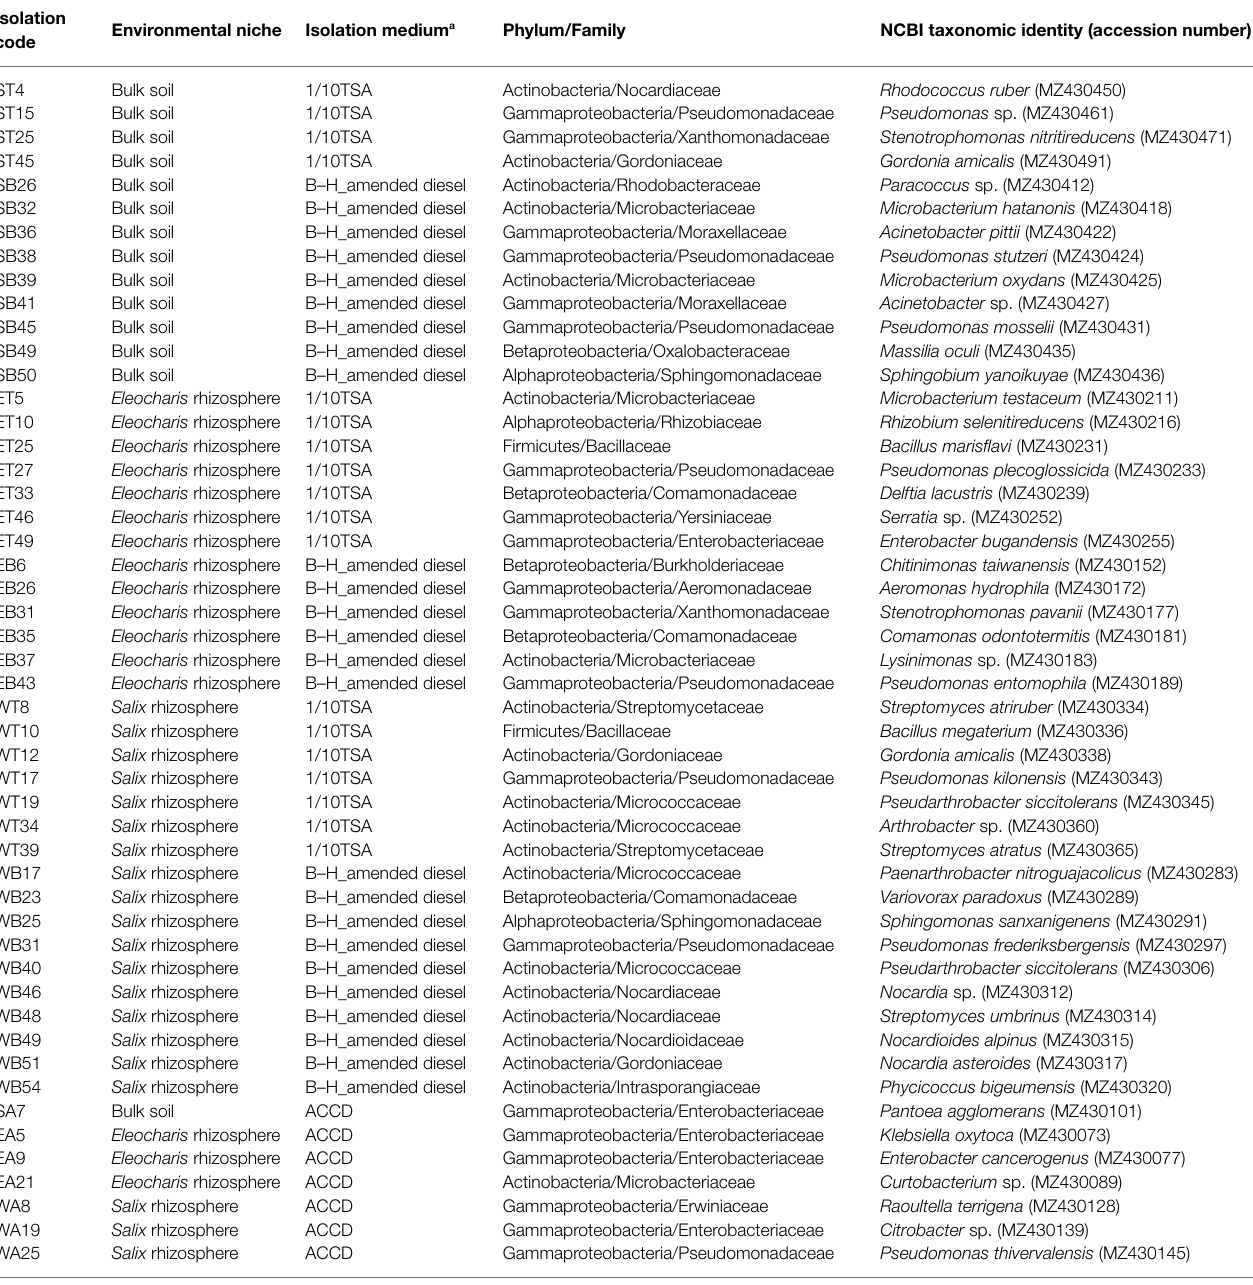
TABLE 1 | List of bacterial isolates used in this